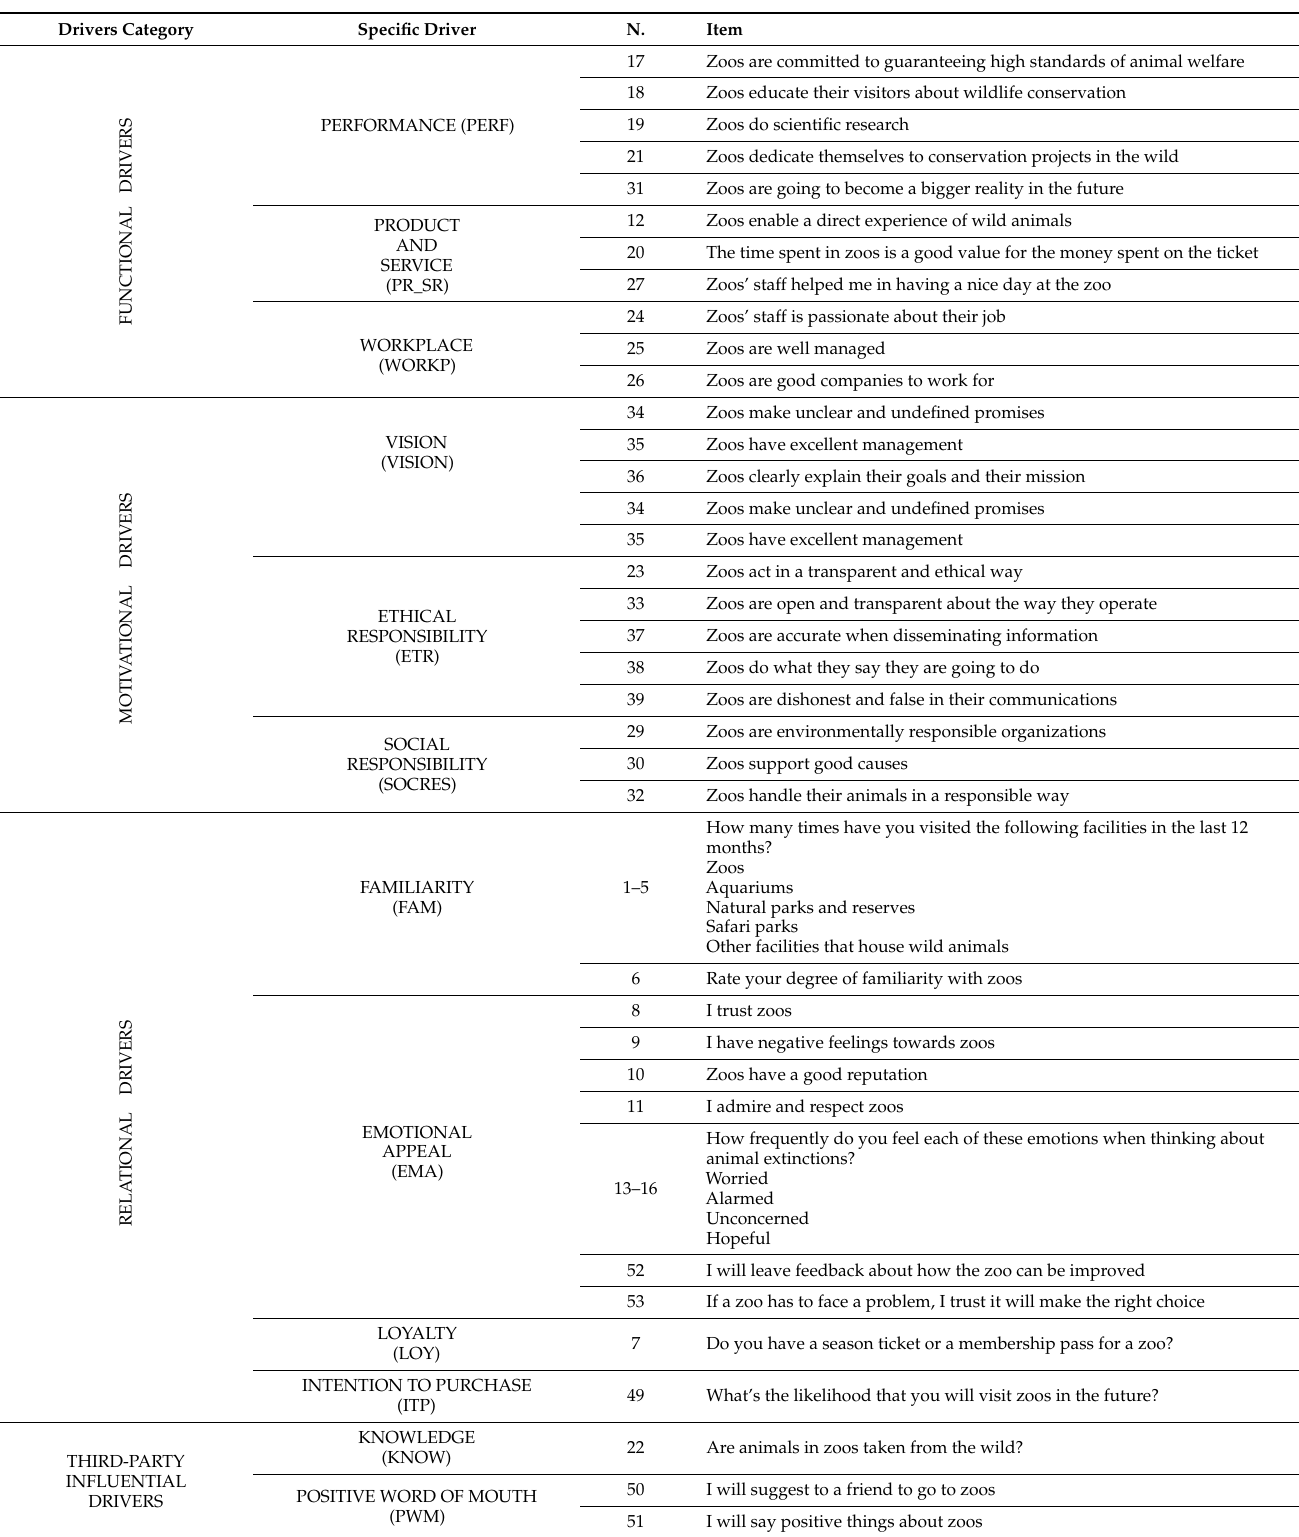
Table 1. ZERS questionnaire layout with items for each specific drive. The complete questionnaire is available in Supplementary Materials